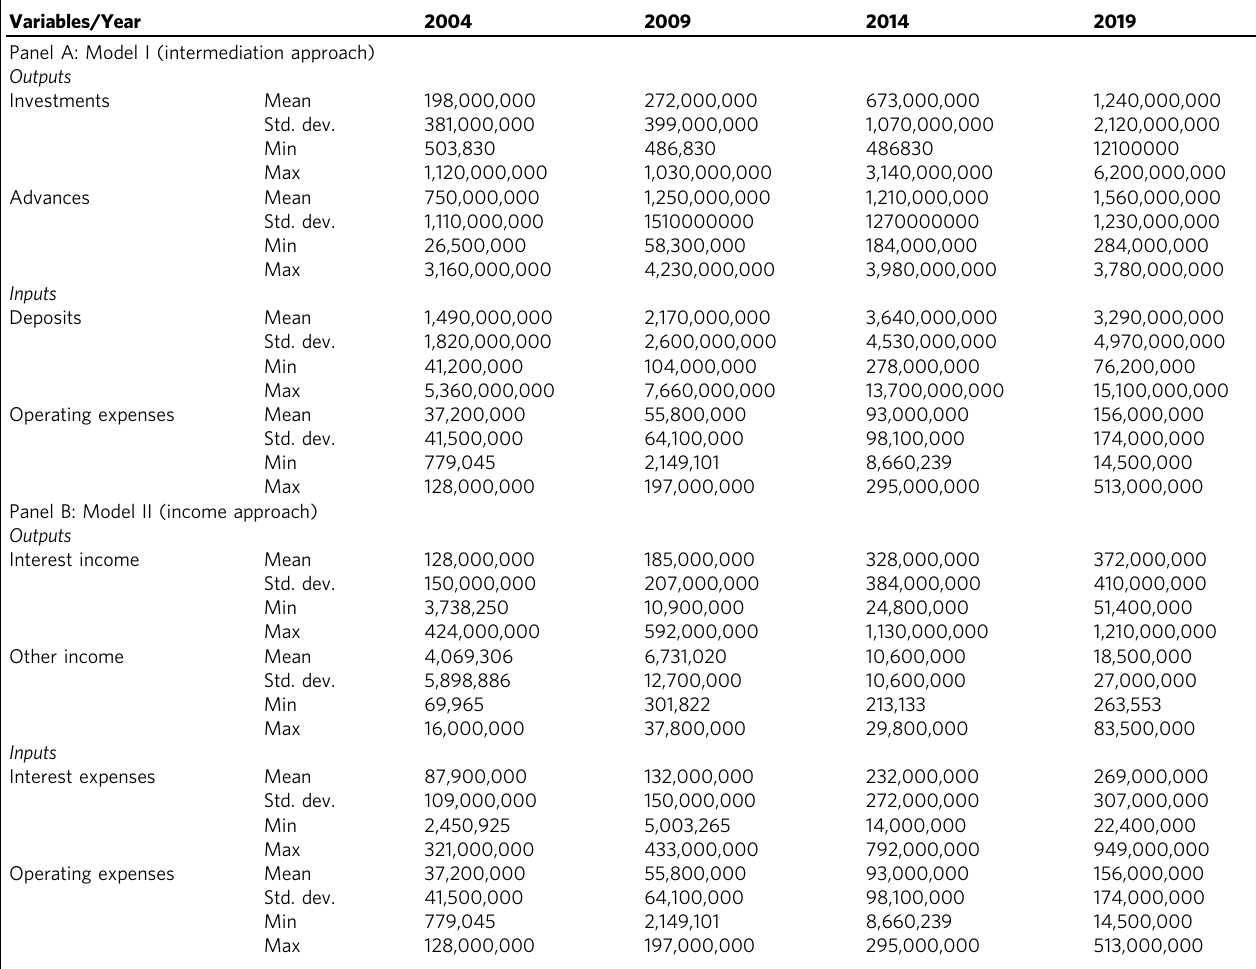
Table 1 Summary statistics of inputs and outputs (amount in Indian rupees).